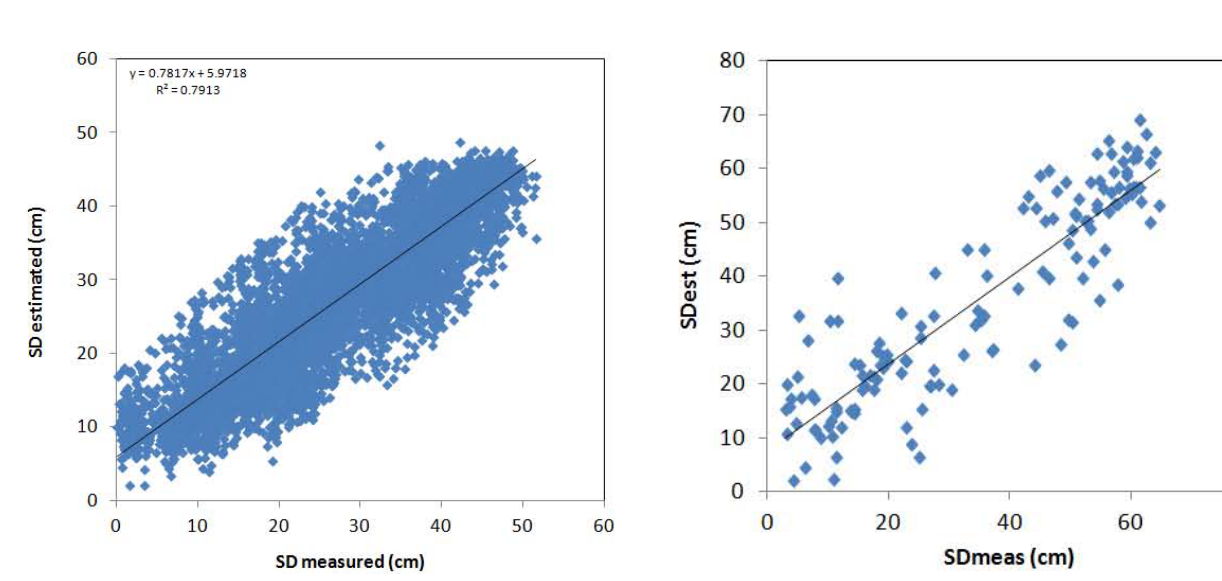
Fig. 8. Temporal trends of T b at X-, Ku- and Ka- bands and the corresponding snow depth (SD, in cm) measurements obtained for the Siberia dataset from 2002 to 2009.